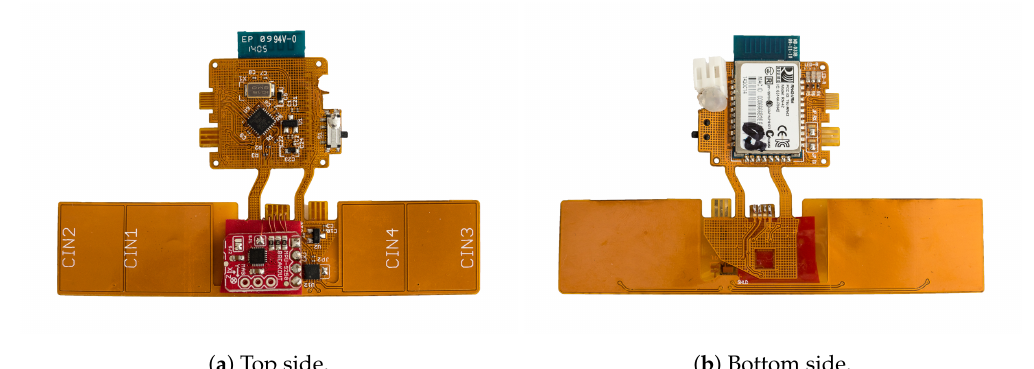
Figure 5. Assembled flexible circuit